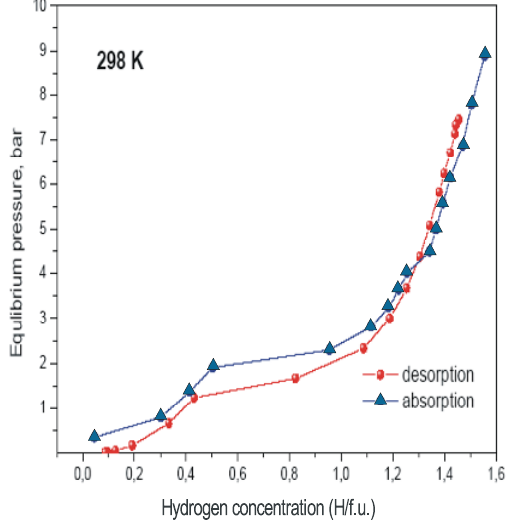
Figure 9. Pressure – hydrogen concentration isotherm for